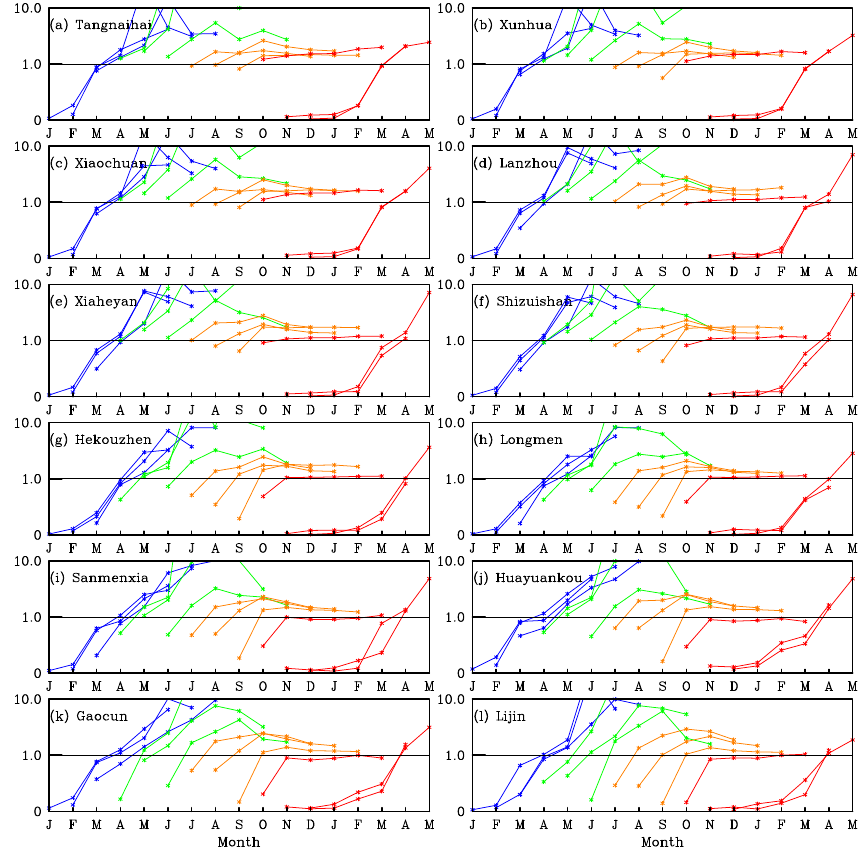
Figure 7. The same as Fig. 5 but for those years with streamflow percentiles at the start month lower than the